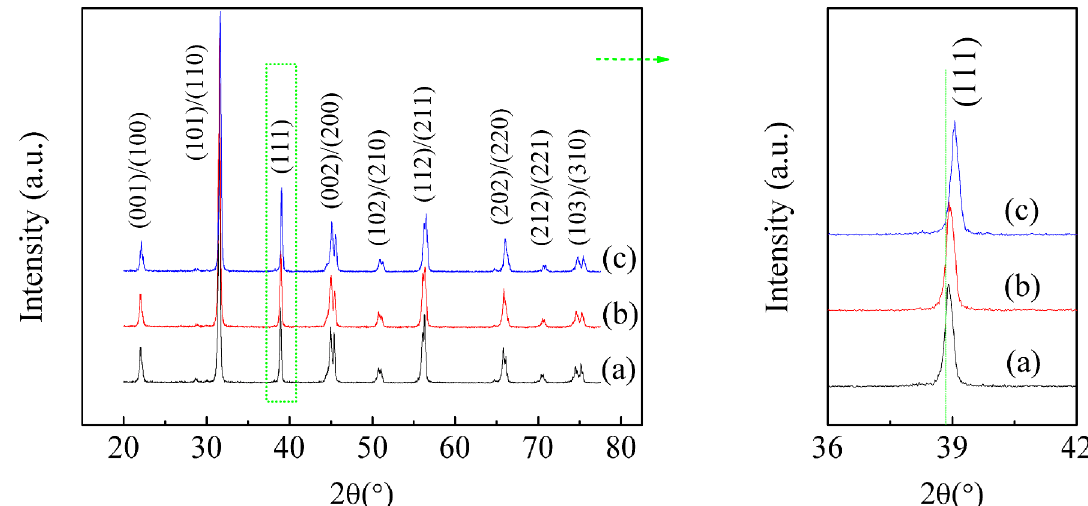
with various content; (a) 0 mol%, (b) 4 mol%, (c) 8 mol%. 3